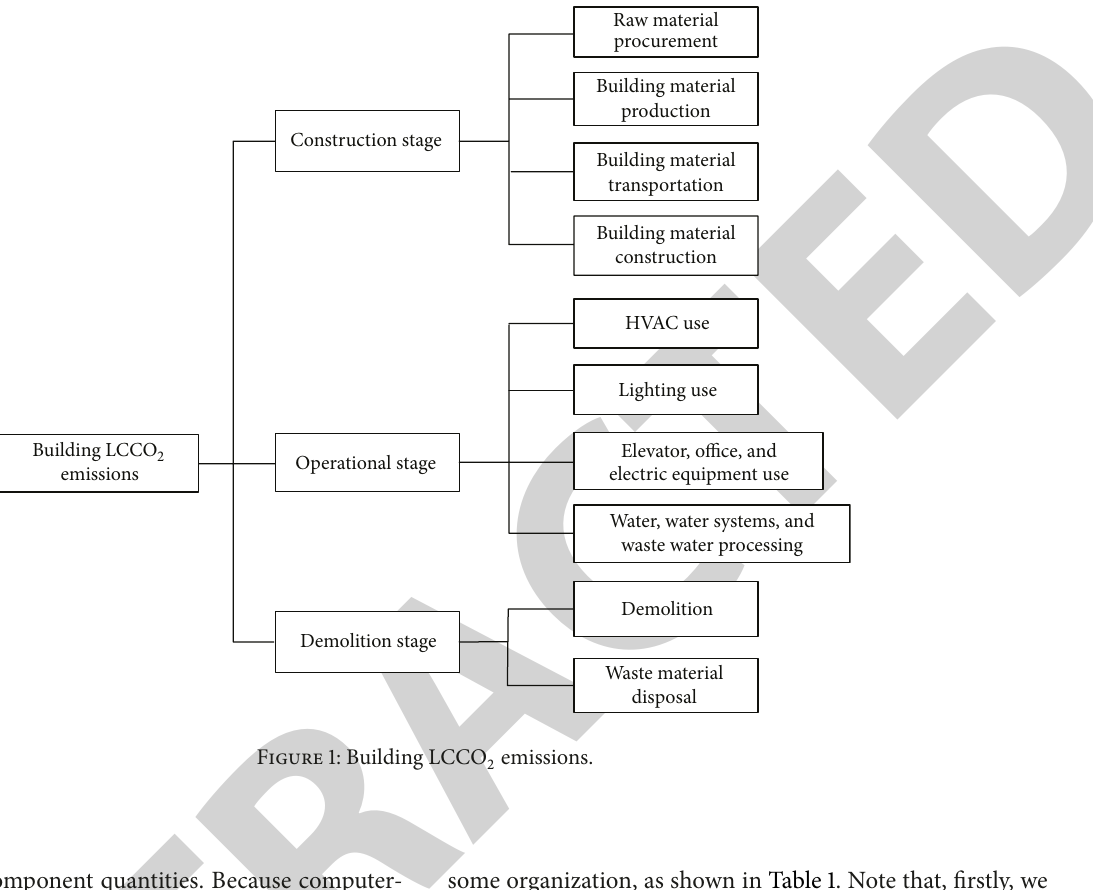
Figure 1: Building LCCO 2